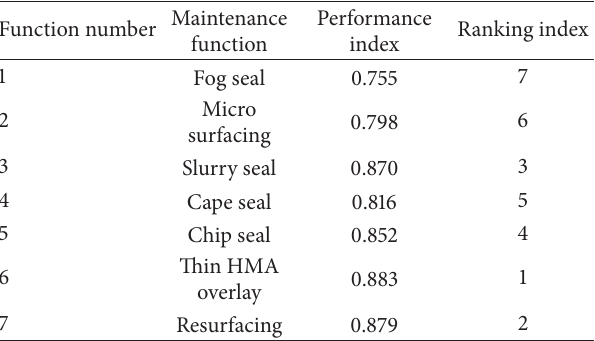
Table 11: Maintenance function ranking and performance ranking using fuzzy